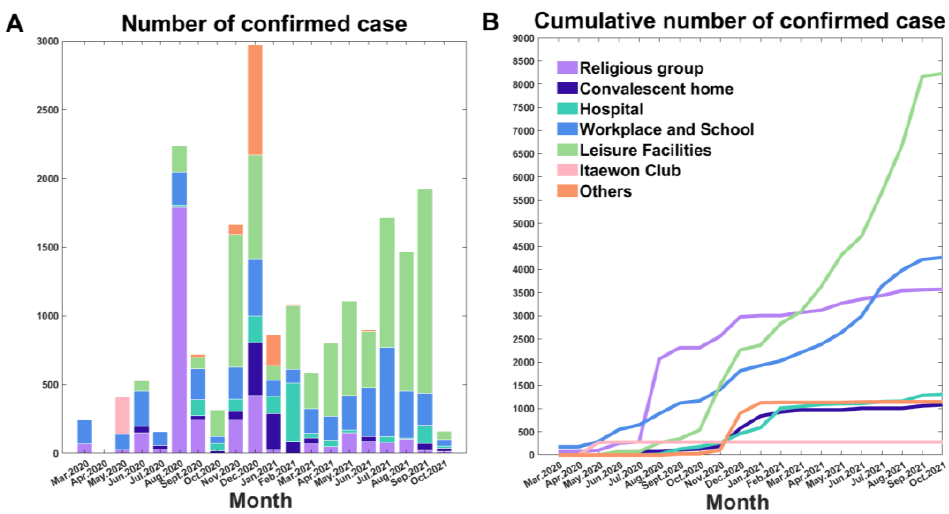
Figure 5. Epidemic curve in South Korea as of October 2021. ( A ). Epidemic curve of monthly cases of confirmed COVID-19 infections in South Korea by confirmed date and colored by cluster category. ( B ). Cumulative curve of monthly cases of confirmed COVID-19 infections in South Korea colored by cluster category.